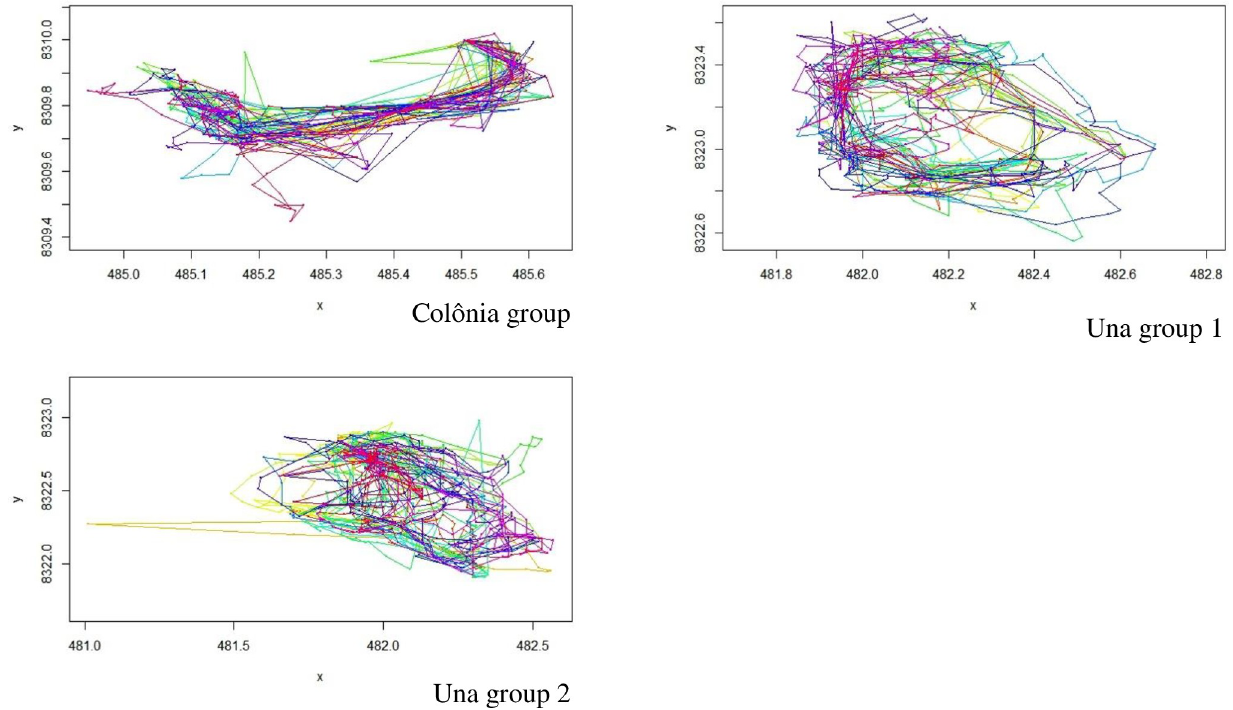
Fig 4. Trajectories of 3 groups (Coloˆnia seasonal trajectories, Coloˆnia de Una, 26 days; Una biological reserve group 1 –annual trajectories, 46 days; group 2 –annual trajectories, 50 days, Brazil), UTM coordinates (UTM Zone 24) on axis. Each colour represents one daily trajectory (of complete days, sleeping-site to sleeping-site).